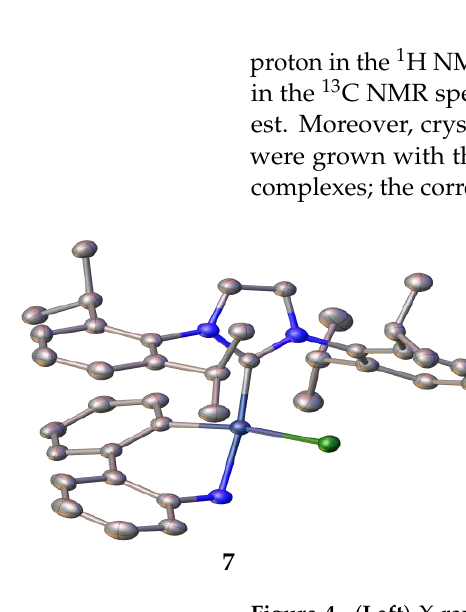
Figure 3. Scheme of the synthesis of palladacycle [Pd(NHC)(NH 2 )(CC)Cl] complexes.